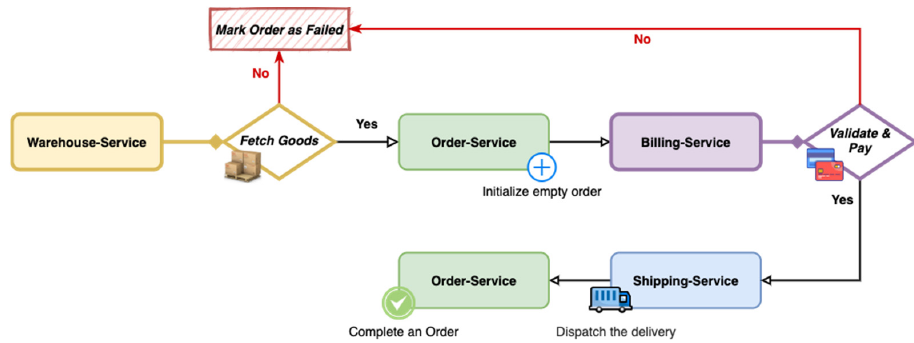
Figure 2. Saga workflow of a standard e-commerce microservices-based system.